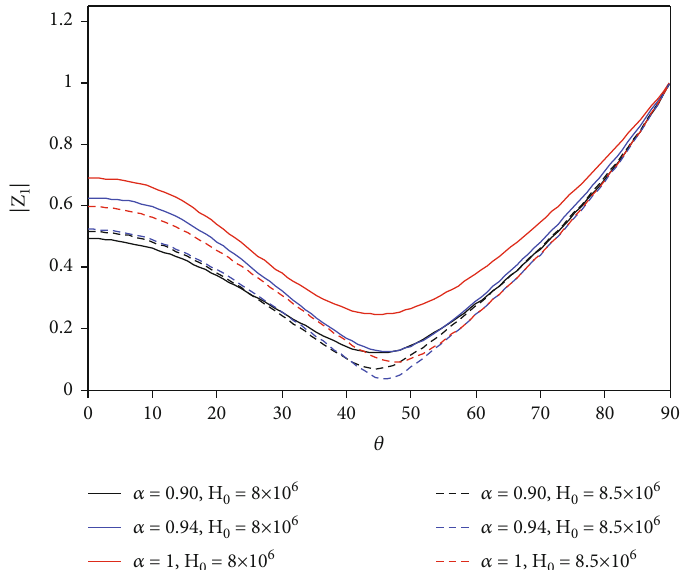
j concerning the angle of incidence θ for various values of the fractional parameter of the 1